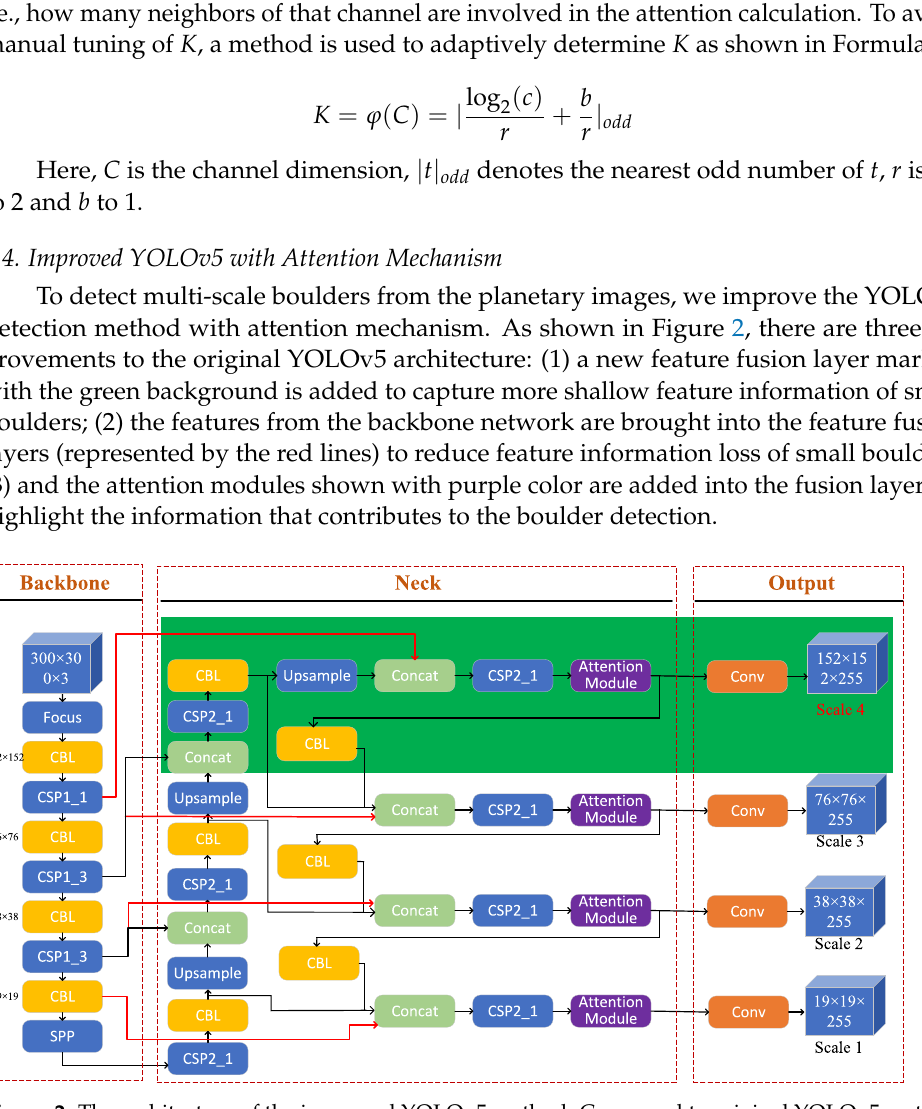
Figure 2. The architecture of the improved YOLOv5 method. Compared to original YOLOv5 method, there are three improvements in the architecture. First, a new fusion layer is added which generates a large scale of feature map with the size of 152 × 152 × 255. Second, new connections represented by red lines have been added to bring feature information from backbone into feature fusion layers. Third, the attention modules are added into feature fusion